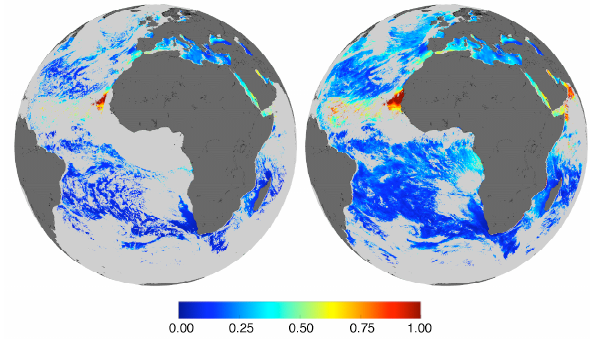
Fig. 2. Monthly mean maps of the aerosol optical thickness at 0.87 µ m (left) and the Angstr¨om coefficient (right) for June 2003, as retrieved from MSG/SEVIRI images using three slots per day (11:15, 12:15 and 13:15 UT). Monthly means for both parameters are computed as the arithmetic average of all clear-sky pixels of the month. MSG data are projected on a regular latitude-longitude grid, and the optical thickness is converted to a different wave- length to enable comparison with available products from POLDER (Fig. 6). The east-west dissymmetry in the images’ coverage is be- cause MSG was not yet at its operational location and was still at 10 ◦ W in June 2003. Note that only three slots per day were avail- able at the time of this study because MSG was in its commissioning phase and we had restricted access to the data. Note also that 5 days (15–19 June) of MSG data were not available at the time of this